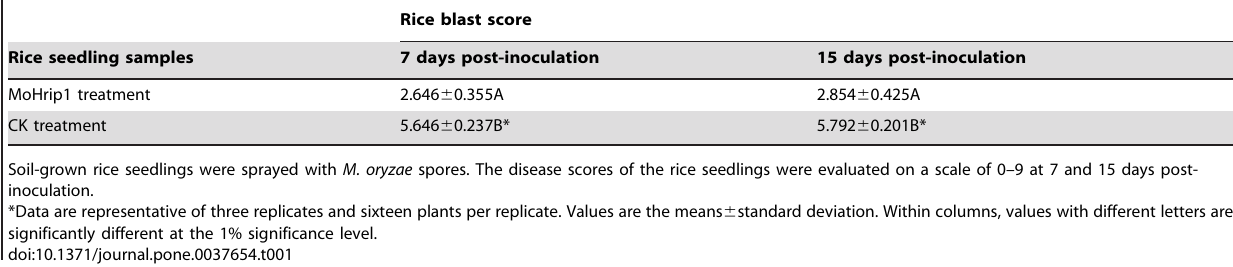
Rice blast score